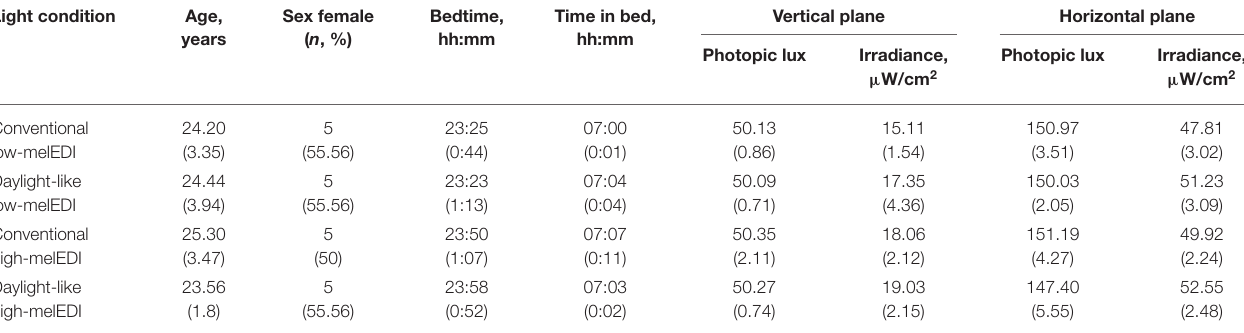
TABLE 1 | Participant demographic and photopic illuminance and irradiance measures for each condition*. Light